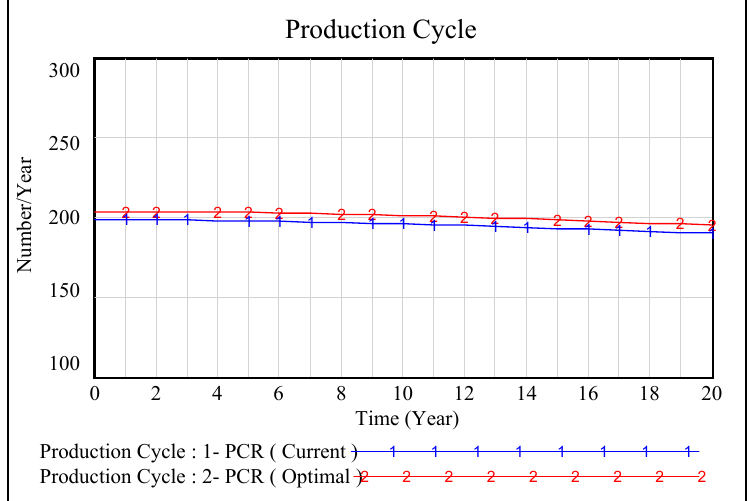
Figure 10. Comparison of the effect of the current and optimal rate of the production cycle on the current variable of the production cycle.